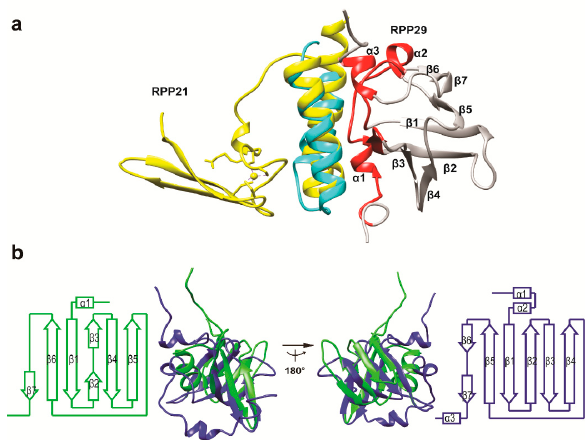
Figure 4. Structural comparison of the RPP21-RPP29 and SF173-YaeO (SF172) systems. ( a ) Ribbon presentation of the RPP21:RPP22 complex structure (PDB ID 2KI7). RPP21 and RPP29 are colored yellow and gray, respectively. The RPP21-binding site in RPP29 is highlighted in red. The region from α 2 to α 3 of the SF173 structure (cyan) was well superimposed onto the α 1 to α 2 region in the RPP21 structure. ( b ) Structural homology between YaeO (green) and RPP29 (blue). 3D structures were superimposed and topology diagrams are presented separately.